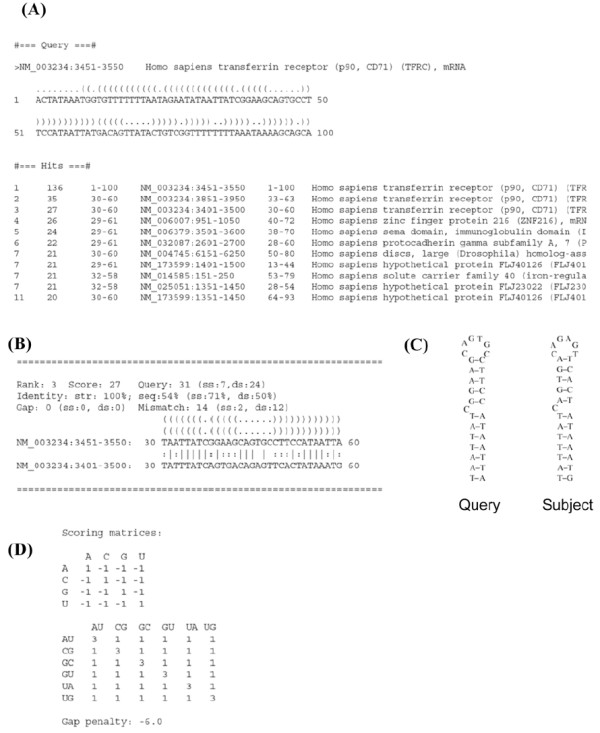
Database search with an RNA structure containing an IRE motif. A structure element (from base 3,451 to base 3,550) in the 3'UTR of human transferrin receptor (NM_003234) was used as a query to search the UTR structure database. (A) The output from RSmatch showing the top 11 hits. The six columns in the ''Hits'' section are, from left to right, rank, alignment score, region in the query, name of the hit, region in the hit, and annotation of the hit respectively. (B) A pairwise alignment of the query structure and a hit structure (NM_003234:3401-3500), which is the region from base 3,401 to base 3,500 of transferrin receptor (NM_003234). The sequence length is shown after "Query" on the first line: a 31 nt long query sequence containing 7 nt in ss region and 24 nt in ds region. Numbers after "Identity" on the second line are percentages of identity of secondary structure (100%), and primary sequence (54%). The latter is further decomposed into two numbers indicating the sequence identity in ss region (71%) and ds region (50%) respectively. The number of gaps in the overall alignment is shown after "Gap", followed by the number of gaps in ss region and ds region, both shown in parenthesis. The same format is used for nucleotide mismatches. Alignments of both structure and sequence are given, where "|" indicates identical nucleotides in either ss region or ds region, and ":" indicates identical secondary structures with different sequences. RNA structures are presented as follows: nested parentheses are used for base pairs and dots are used for nucleotides in ss regions. (C) The RNA structures corresponding to the query and the subject (hit) structure in (B). (D) Scoring matrices and the gap penalty used in the search. T and U are used interchangeably in this study.